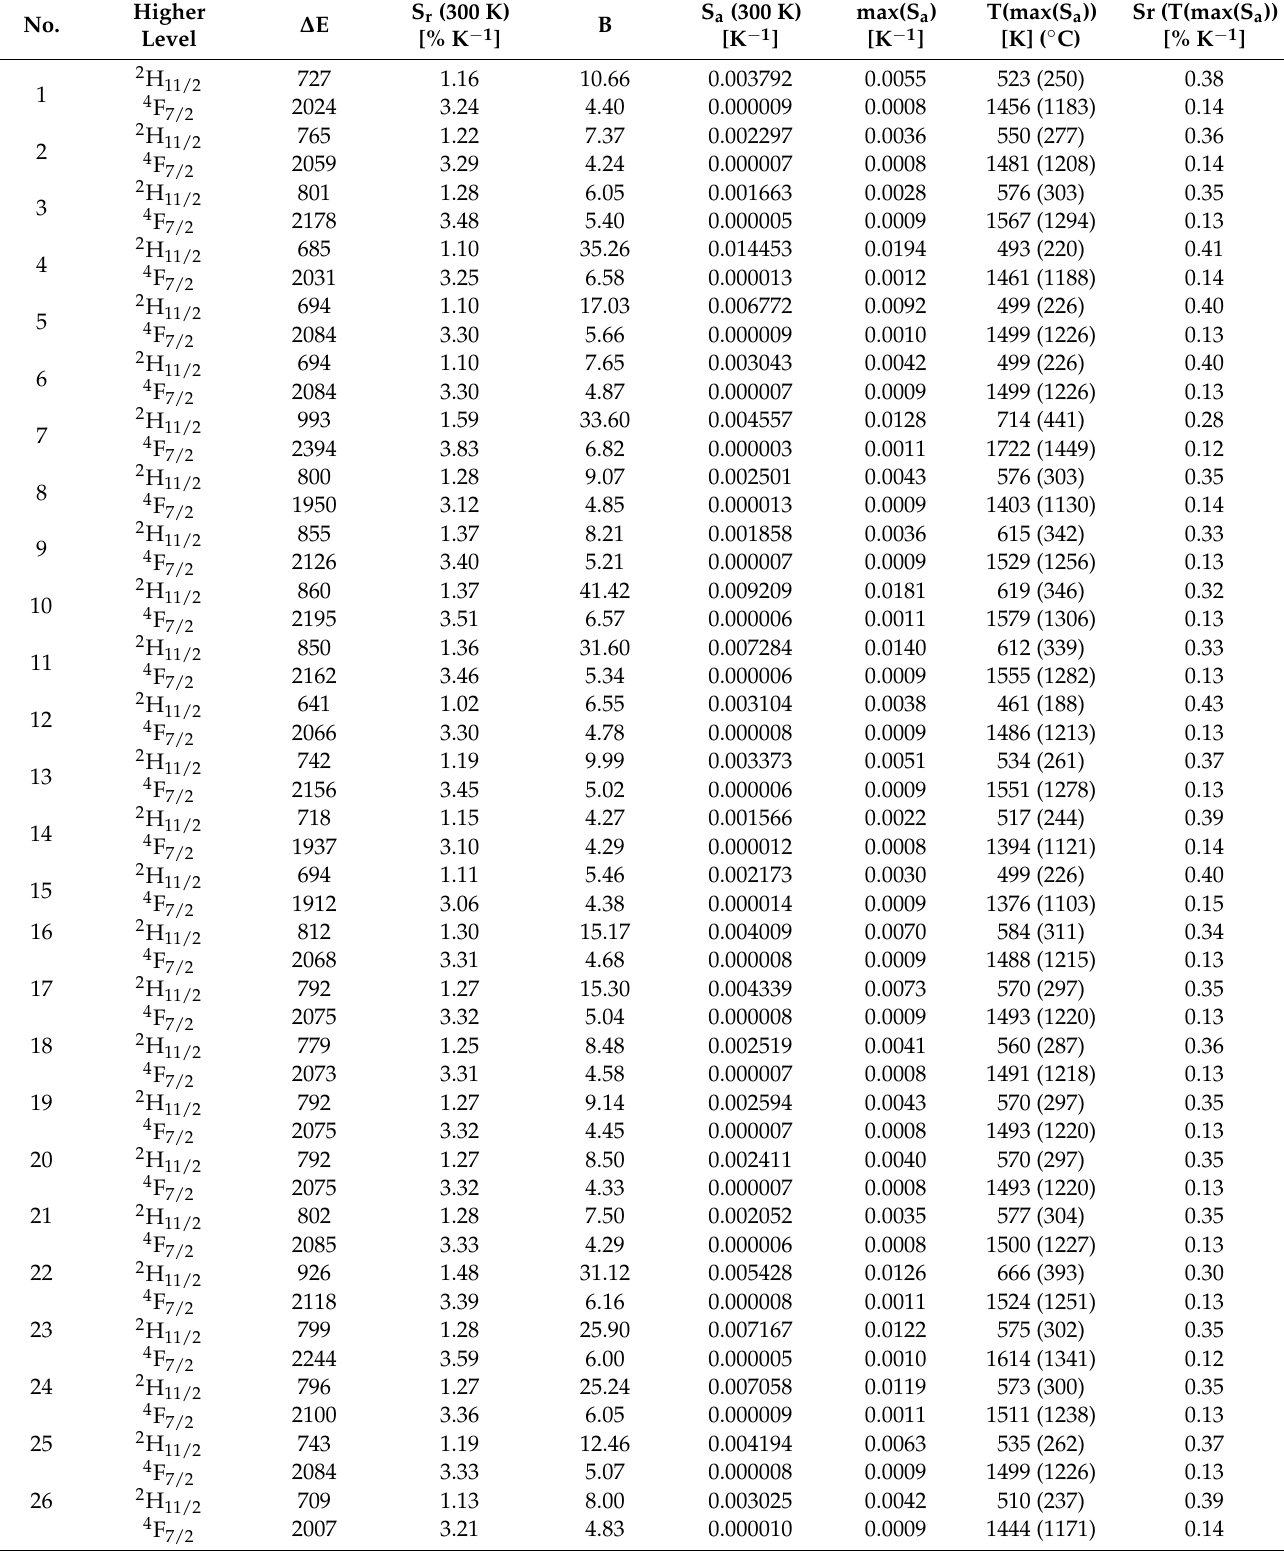
Table 5. Calculated luminescence thermometry parameters: energy gaps ( ∆ E ) from Er 3+ 4 S 3/2 level to 2 H 11/2 and 4 F 7/2 , relative temperature sensitivities ( S r ) for LIRs between selected levels, B LIR parameters, absolute sensitivities at room temperature ( S a ), maximum sensitivity value ( S amax ), temperatures at which maximum absolute sensitivity occurs ( T ( S amax )), and relative sensitivities at T ( S amax ) ( S r ( T ( S amax